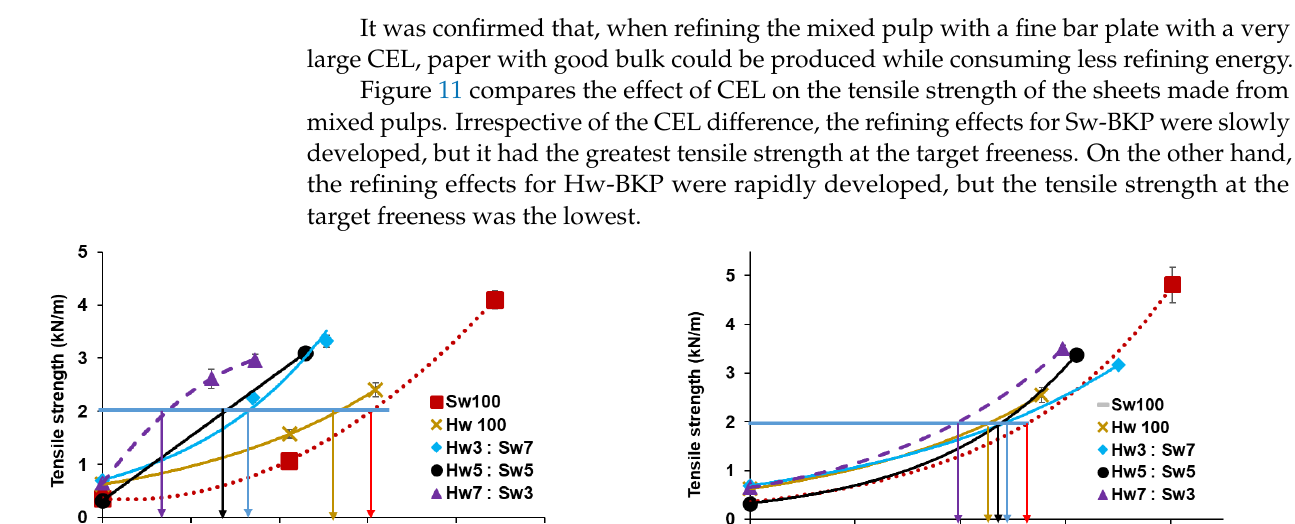
Figure 10. Effect of CEL on bulk of paper made of the mixed pulps: ( a ) PA55; ( b ) PB97. It was confirmed that, when refining the mixed pulp with a fine bar plate with a very large CEL, paper with good bulk could be produced while consuming less refining en- ergy.